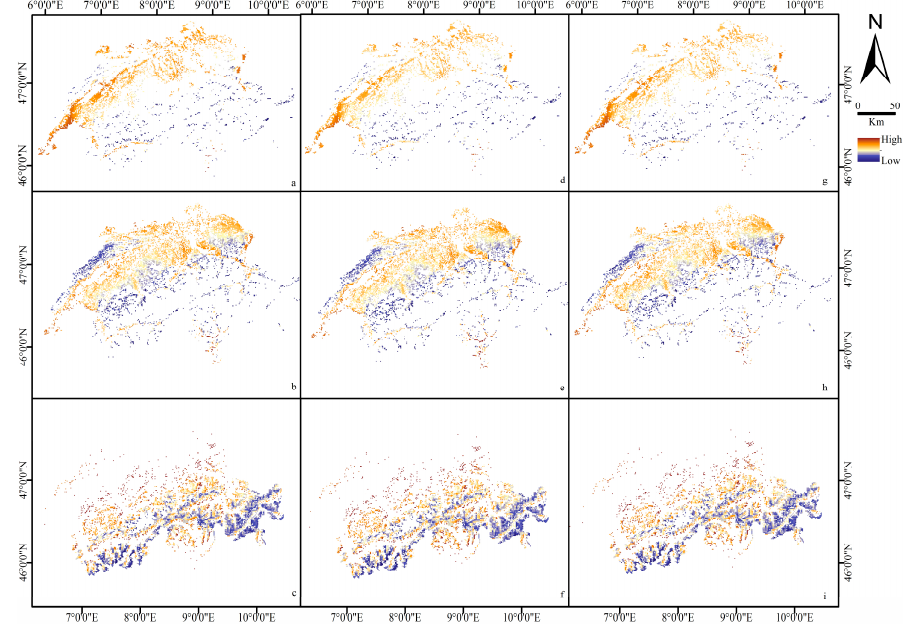
Figure A4. Spatial variability of yearly mean temperature: (a–c) croplands (–4–12°C), croplands/natural vegetation mosaic (-––13°C), and grasslands (–9–14°C), respectively, for the year 2000; (d–f) croplands (–4–13°C), croplands/natural vegetation mosaic (–4–13°C), and grasslands (–9–15°C), respectively, for the year 2007; and (g–i) croplands (–6–12°C), croplands/natural vegetation mosaic (–5–12°C), and grasslands (–10–13°C), respectively, for the year 2010.